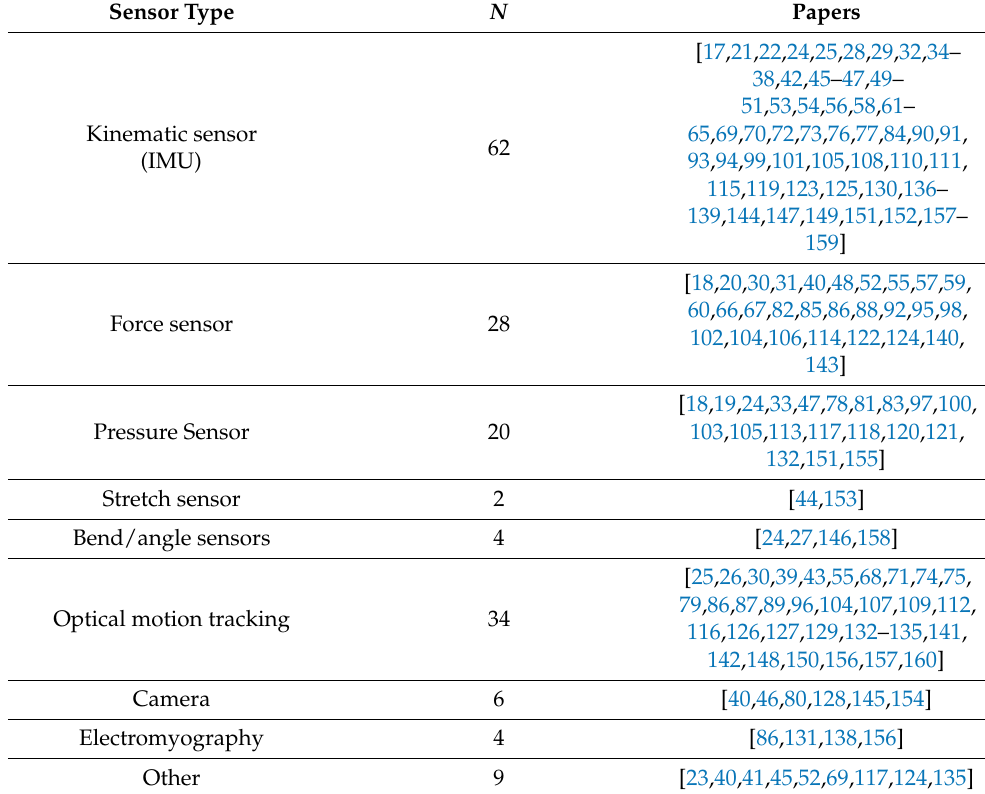
Table 2. Papers classified according to the sensors